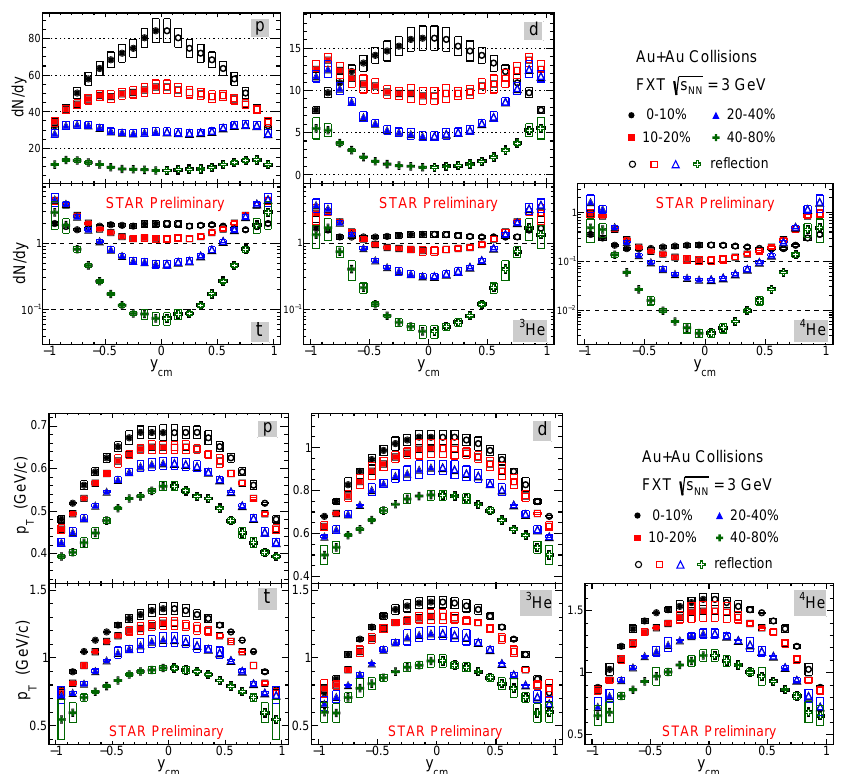
〉 distribution of proton, deuteron, triton, T (cid:112) = 3 GeV. Solid markers obtained by real s NN